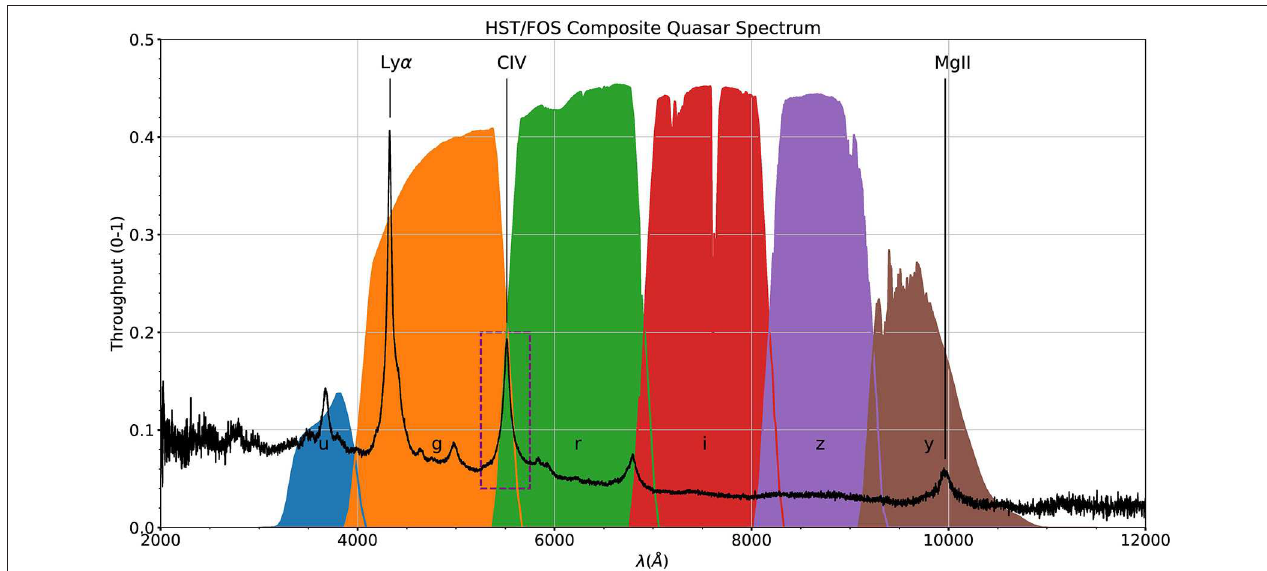
FIGURE 8 | Throughput curves for the 6 LSST photometric bands ( ugrizy ), shown as a function of wavelength (in Å). The black solid line is the HST/FOS composite quasar spectrum (Zheng et al., 1997) and the dashed box in purple highlights the importance of quasar selection . The spectrum is shown at a redshift, z = 2.56. The composite spectrum is downloaded from